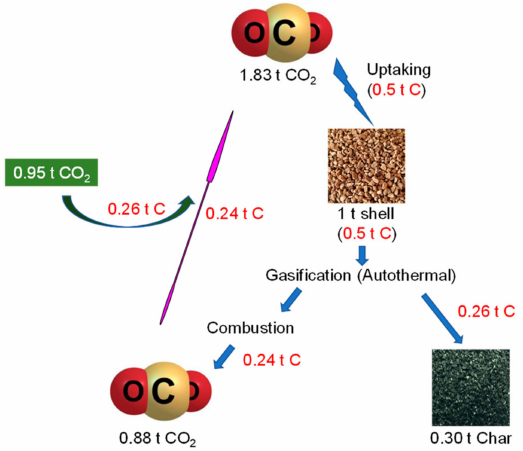
Figure 5. A schematic diagram showing negative CO 2 emission from the gasification